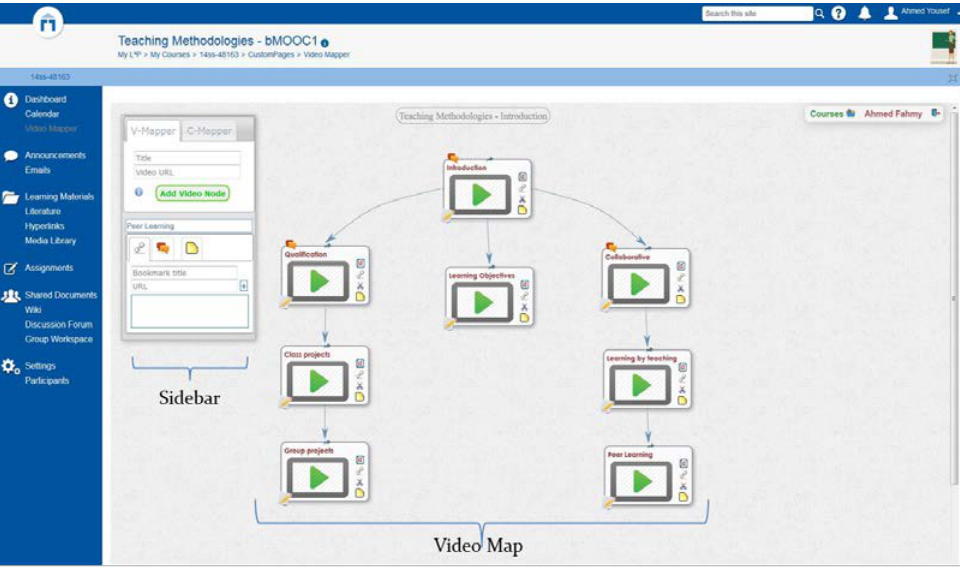
Figure 2. L 2 P-bMOOC